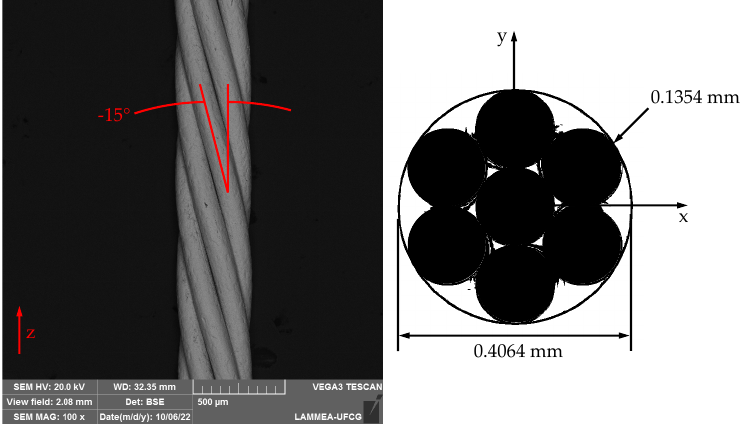
Figure 1. SEM image of the side view and schematic drawing of a cross-section of the NiTi micro cable.